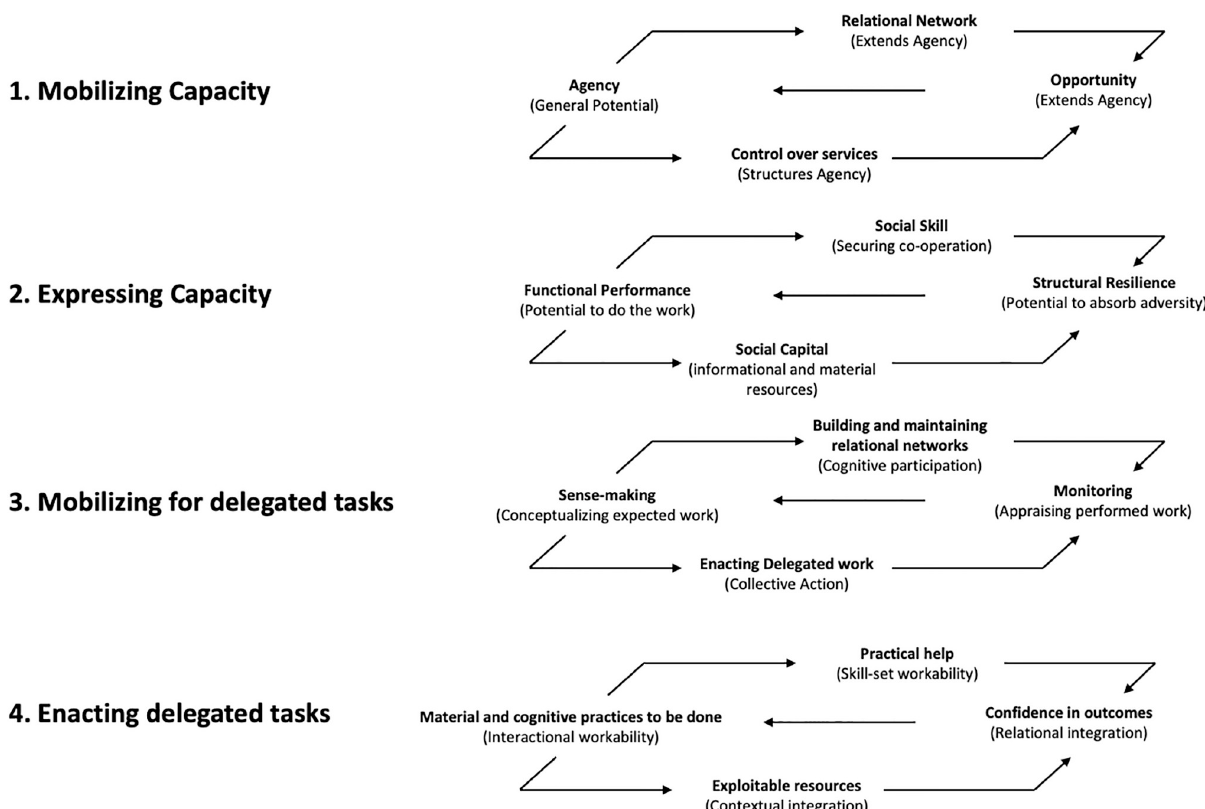
Fig 1. Conceptual map of burden of treatment theory adapted from May et al.